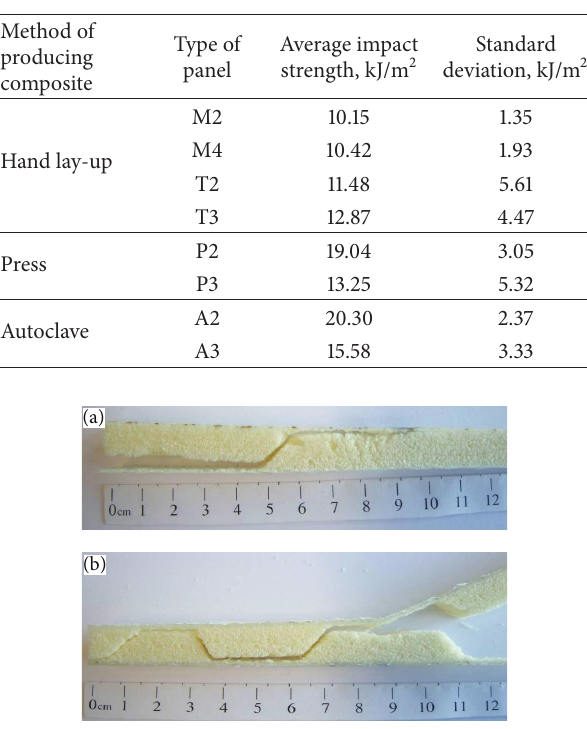
Table 5: Results of impact strength according to Charpy’s method.